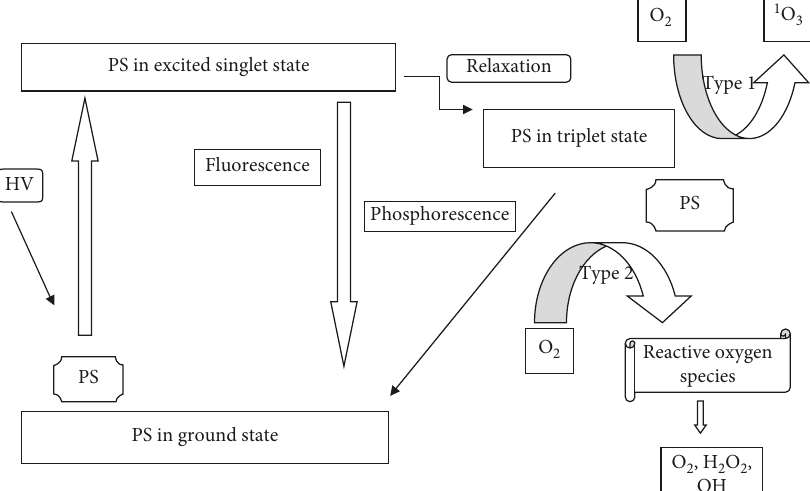
Figure 17: Schematic representation of a photosensitizer before and after